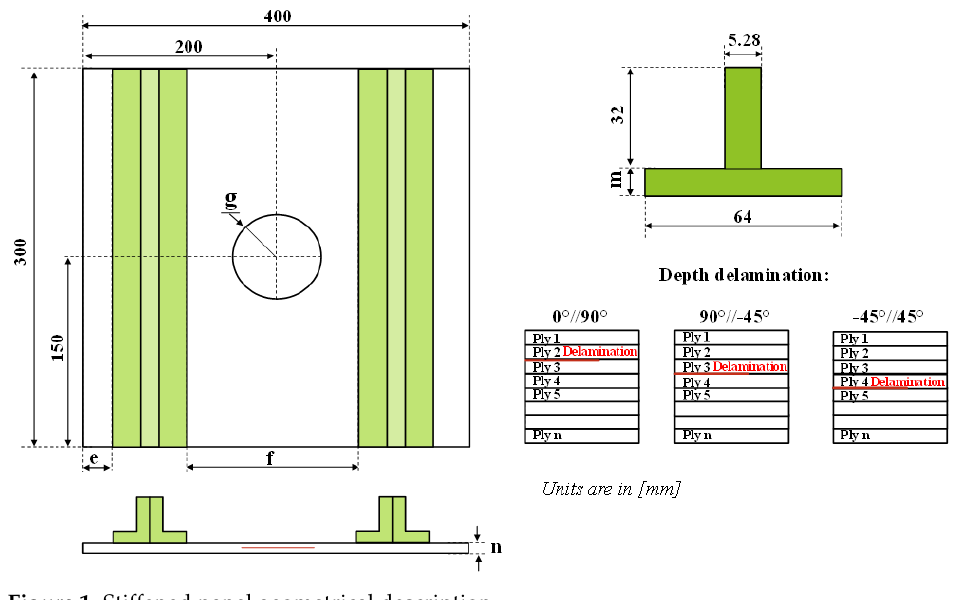
Figure 1. Stiffened panel geometrical description. Table 1. Geometric dimensions of the analysed configurations (units are [mm]).